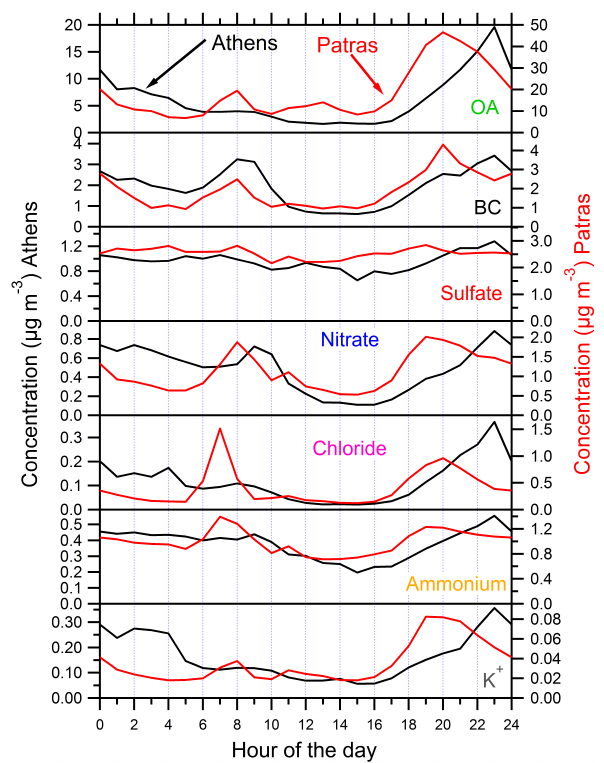
Figure 3. Average diurnal profiles for the main PM 1 components during the Athens and Patras campaigns. The concentration of PM 1 in Patras is shown on the right y